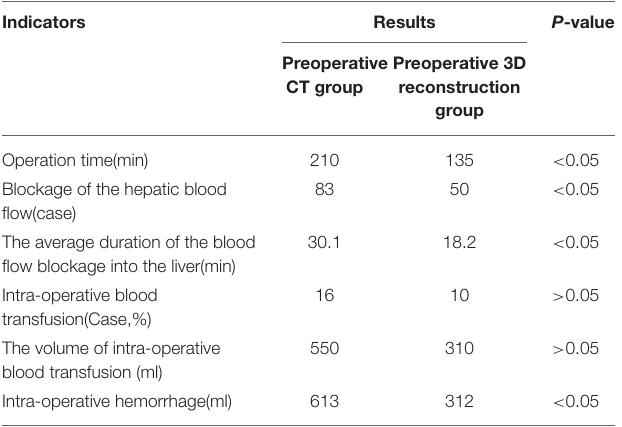
TABLE 4 | The intra-operative condition between the preoperative CT group and the preoperative three-dimensional reconstruction group.